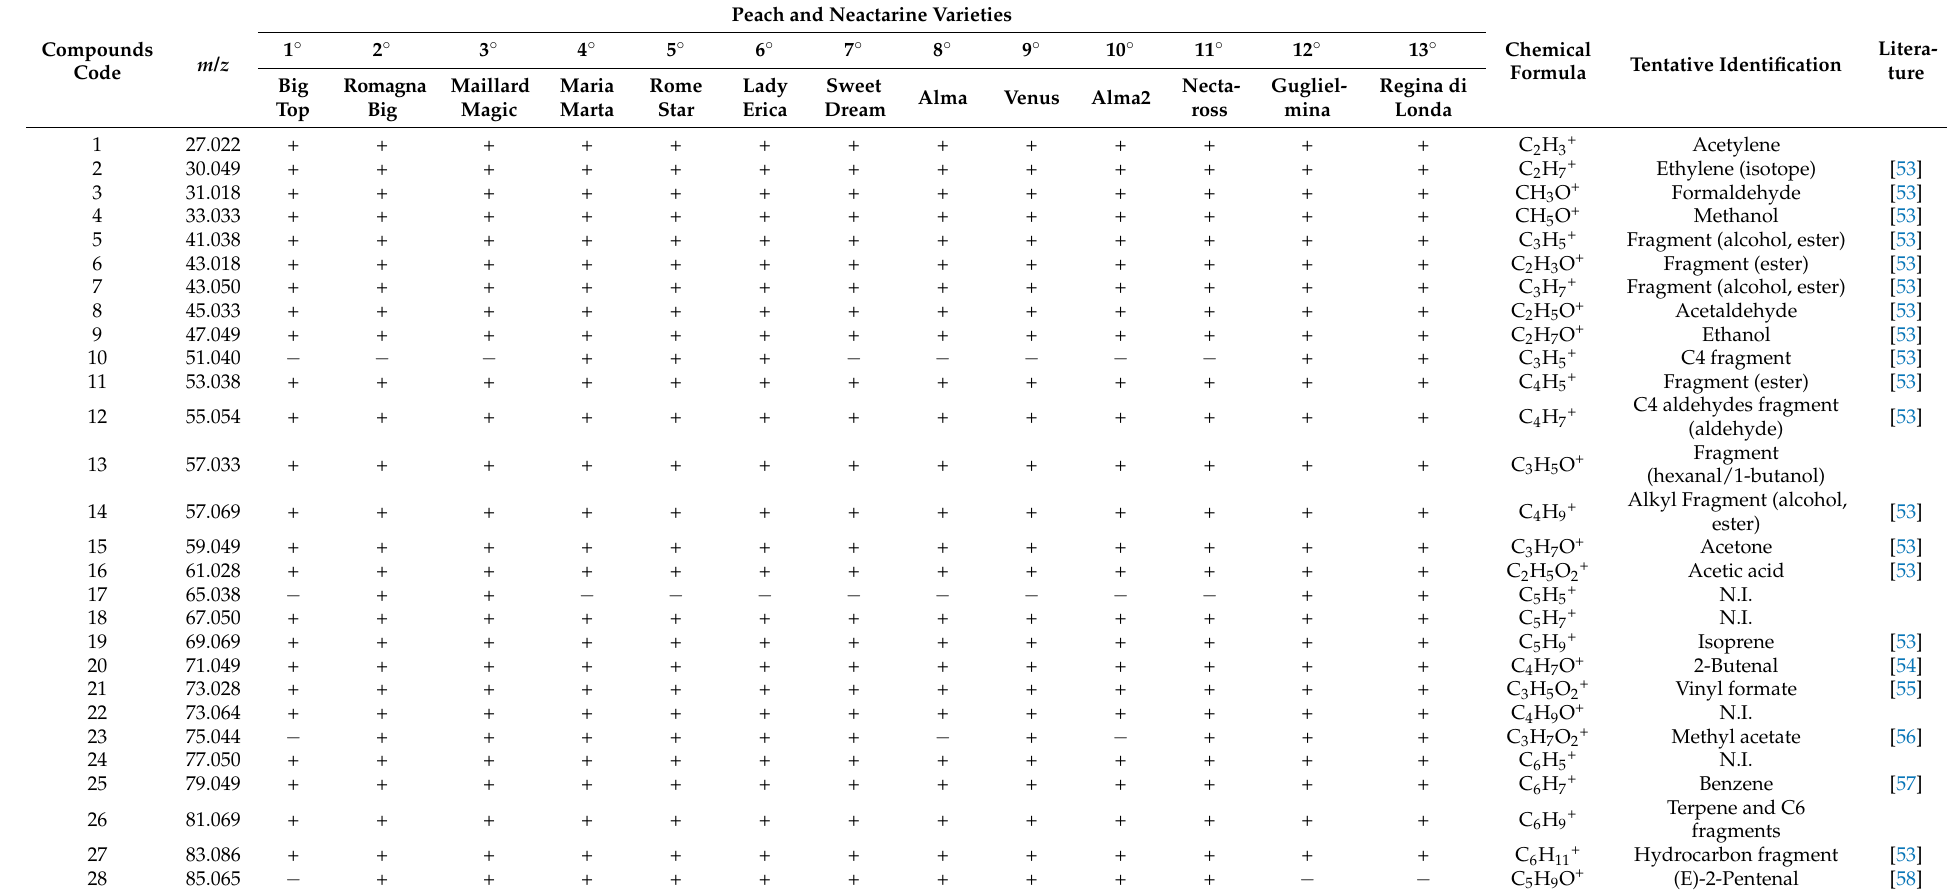
Table A1. Compounds identified via PTR-ToF-MS: compounds number, mass/charge ( m / z ) ratios, tentative identifications, chemical formula for each VOCs evolved from different peach fruit varieties. The tentative identification was made compared each VOC with those previously reported in the peach literature. Moreover, the symbols indicate the presence (+) or absence ( − ) of each compound. In bold were highlighted the compounds better characterized the SSCPs.